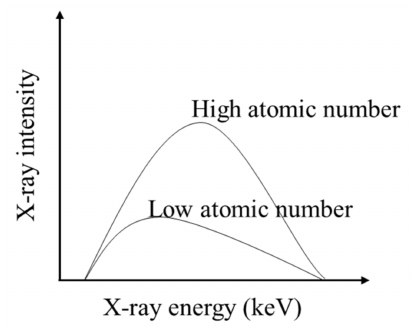
Figure 4. Influence of atomic number of the target material on the X-ray